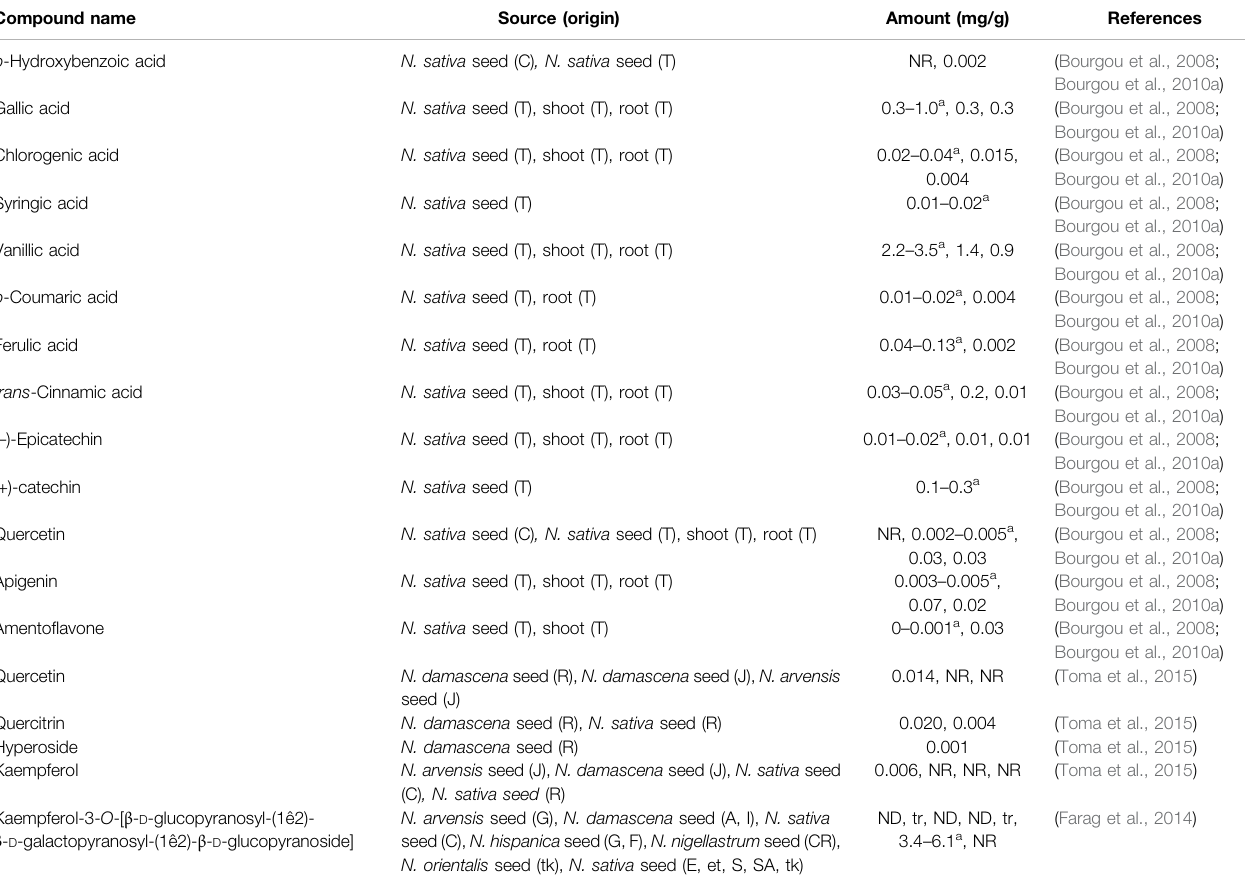
TABLE 3 | Example of phenolic compounds found in Nigella